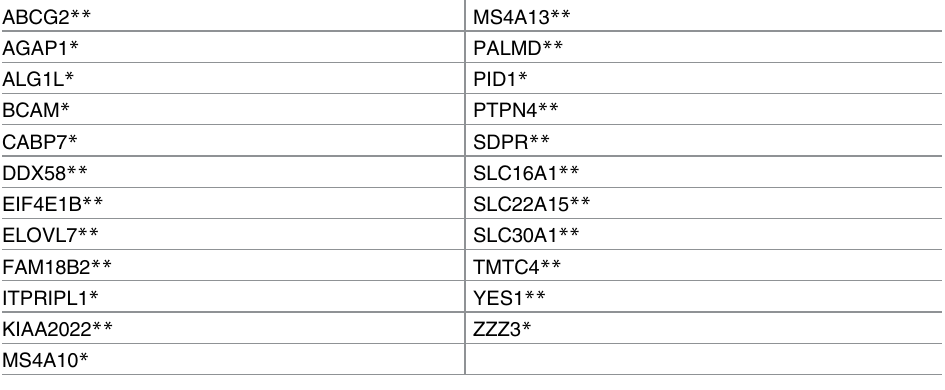
Table 6. Proteins that show differences between VSMC and non-vascular